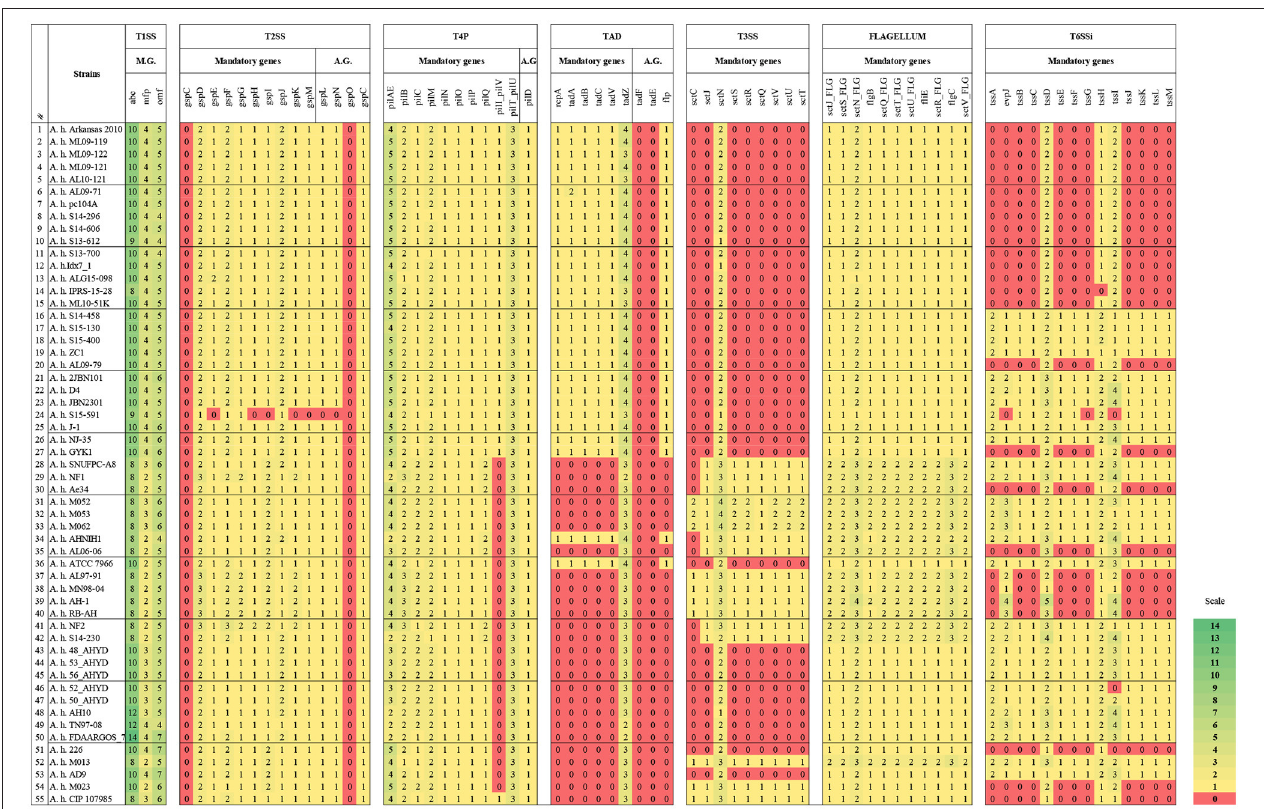
FIGURE 2 | Core and accessory proteins of secretion systems, T4P, Tad, and flagella encoded in A. hydrophila genomes. Numbers and color represent the number of copies of each listed gene. The strains are listed in the same order as Table 1 and Figure 1 (the first 27 strains are vAh strains). tssD is also known as hcp and tssI is also known as vgrG . A.G. indicates Accessory genes.